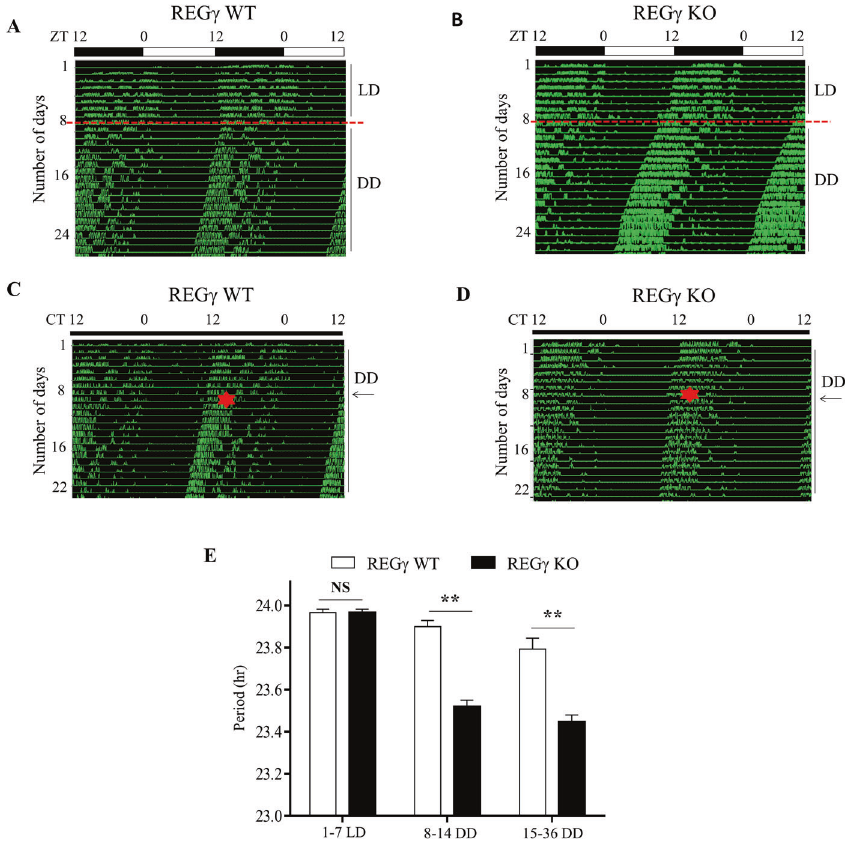
Fig. 1 Light induced circadian phase shift in REG γ KO mice. A The actogram of 5-month-old REG γ WT control mice; B the actogram of littermate REG γ KO male mice in 12/12 h light – dark (LD) cycle followed by dark – dark (DD) for 3 weeks. For circadian phase change experiment, mice were fi rst entrained to complete dark – dark (DD) cycle for 1 week and then placed in complete darkness for 3 weeks, and then a light pulse for 15 min at CT15 on day 8 in dark – dark (DD) was applied. REG γ WT mice in C did not accomplish the phase delay behavior of circadian rhythm, REG γ KO mice in D executed phase delay behavior upon light stimulus. Red dotted lines in A , B show the start day for constant darkness. Red star and black arrows in C , D indicate the day when a light pulse was applied. E Bar graph represent intrinsic periods (natural free running periods) of mice during the fi rst week of 12/12 h LD cycle and initial 3 weeks in constant darkness. Values in E represent the mean ± SD. ** p < 0.01; t test, WT vs. KO. The sample size was n =